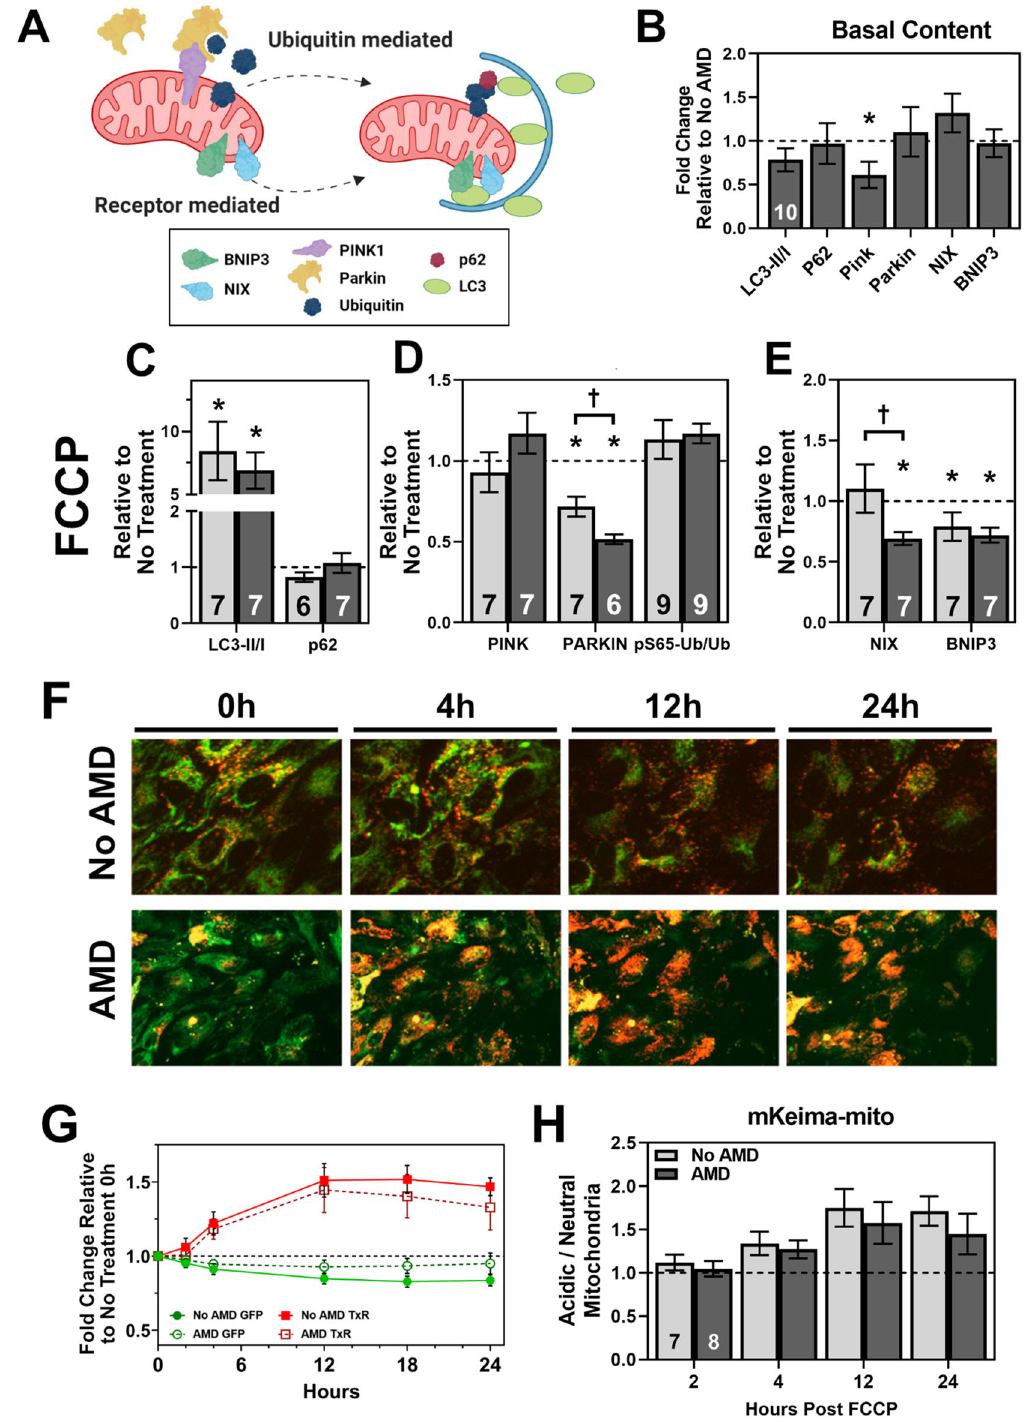
Figure 5. Assessment of mitophagy after FCCP induced stress. ( A ) Summary of ubiquitin-mediated and receptor-mediated mitophagy pathways. Membrane depolarization leads to PTEN-induced kinase 1 (PINK1) activation, leading to PARKIN (E3 ubitiquin-ligase) ubiquitination of outer membrane proteins which initiates autophagosome formation. Receptor-mediated mitophagy proteins BCL2/adenovirus E1B 19 kDa protein-interacting protein 3 (BNIP3) and BCL2/adenovirus E1B 19 kDa protein-interacting protein 3-like (NIX) are stimulated by PINK1, as well as other stressors including hypoxia. BNIP3 and NIX directly interact with autophagosome machinery to induce mitophagy. ( B ) Basal content of mitophagy proteins in AMD RPE relative to No AMD (dashed line). ( C , D ) Quantification of LC3-II/I and p62 ( C ), ubiquitin-mediated mitophagy proteins PINK, PARKIN, and pS65-Ub / total Ub ( D ), or receptor-mediated mitophagy proteins NIX and BNIP3 ( E ) proteins after 4 h of FCCP treatment in No AMD (light bar) or AMD (dark bar). ( F ) Representative images of mKeima-mito from No AMD (top) and AMD (bottom) RPE. ( G ) Traces of neutral (green, circles) and acidic (red, squares) after treatment with FCCP for No AMD (filled symbols, solid line) and AMD (open symbols, dashed line) RPE. ( H ) Ratio of acidic to neutral mitochondria in primary RPE from No AMD or AMD donors. All data shown is mean ± SEM. Number of samples for each experiment is provided in the bars. Results of 2-way ANOVA are treatment effect (p < 0.01) and disease effect ( p = 0.40). Panel A produced in